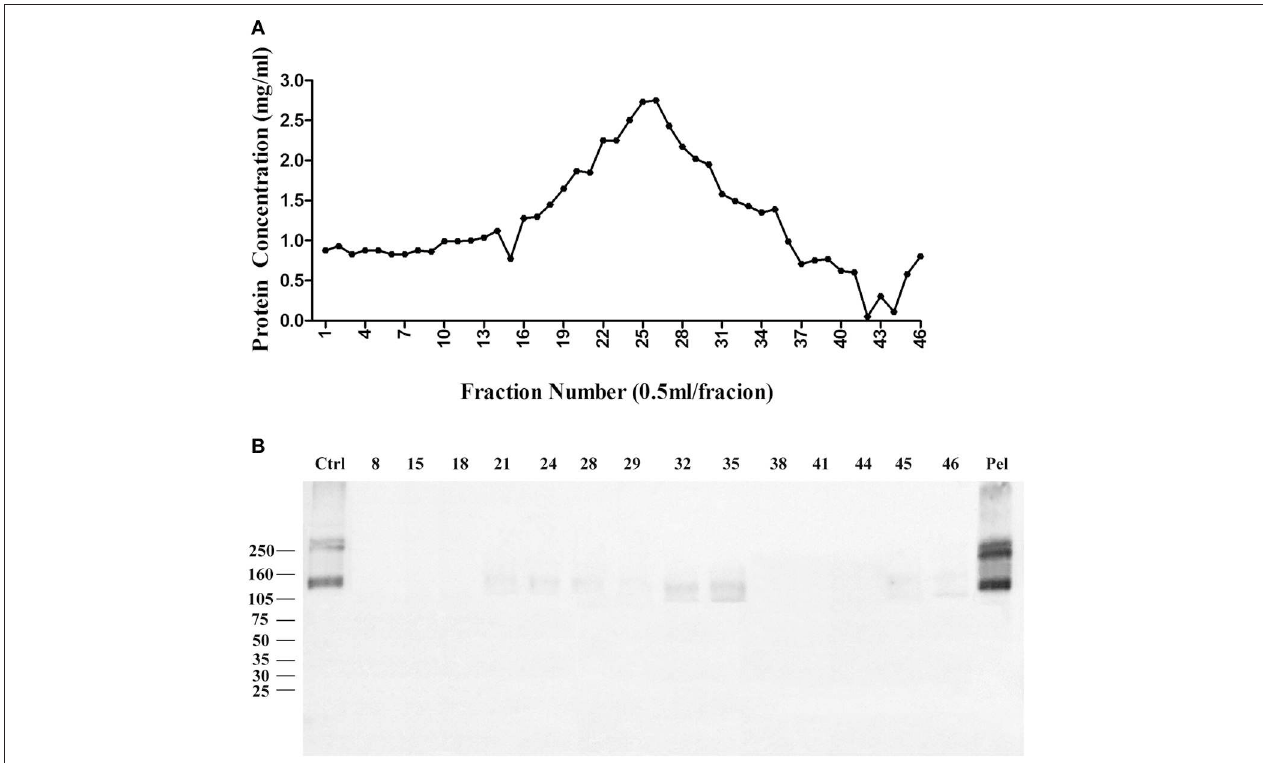
FIGURE 3 | A β O binding protein p140 and p260 are not extracted from cortical membranes by Zwittergent. Cortical membranes were extracted by Zwittergent, proteins separated by ultracentrifugation, and fraction assayed by ligand blots to detect A β O binding proteins. (A) The protein concentration in each fraction. (B) A β O ligand blots for selected fractions and pellet. Results show p140 and p260 remain with the pellet of Zwittergent-extracted